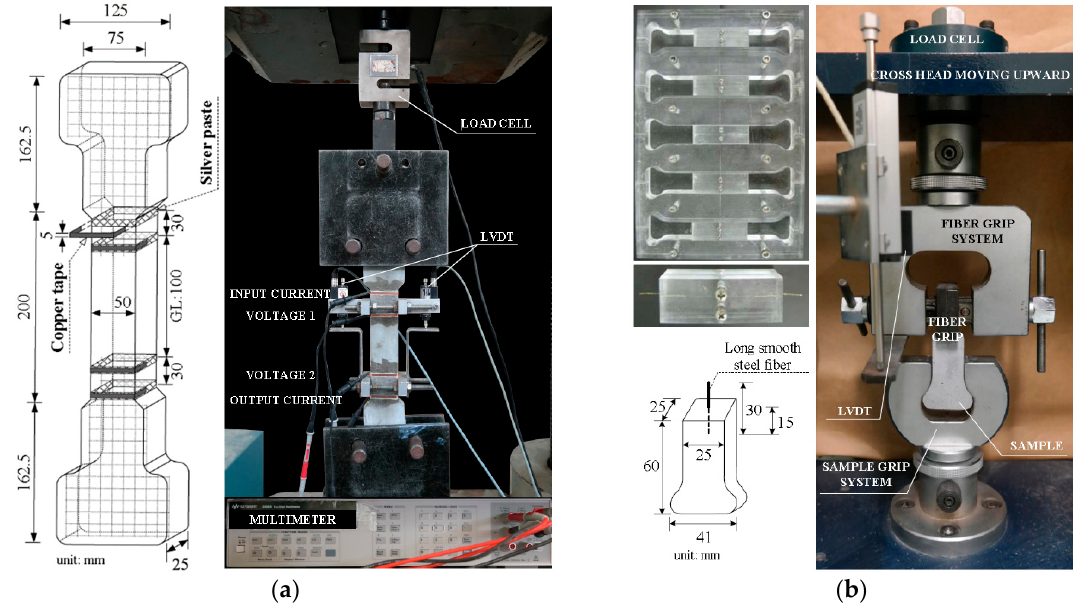
Figure 5. Geometries of the specimens and the test setups: ( a ) direct tensile test and ( b ) single-fiber pullout test.